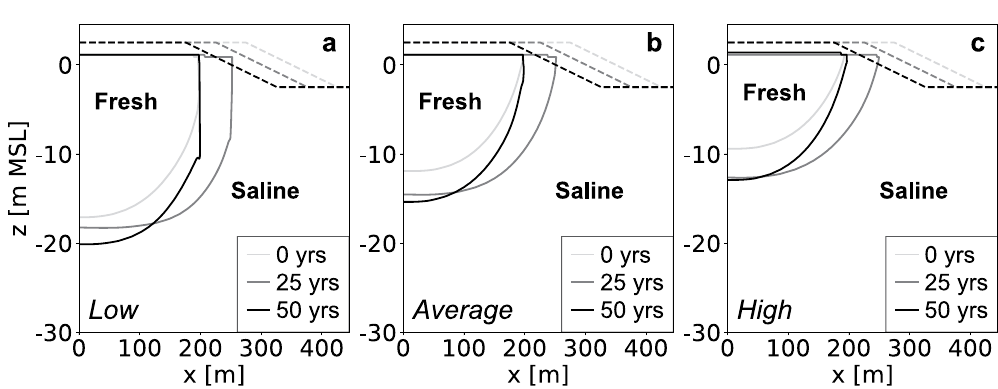
Figure 5. Simulated growth of the fresh groundwater lens for low (left), average (centre), and high (right) estimates of the specific yield. All images contain the fresh-salt groundwater interface of 1 g TDS L − 1 (solid lines) and the surface elevation (dashed lines) at the start (light grey), middle (dark grey) and end (black) of the simulation period.